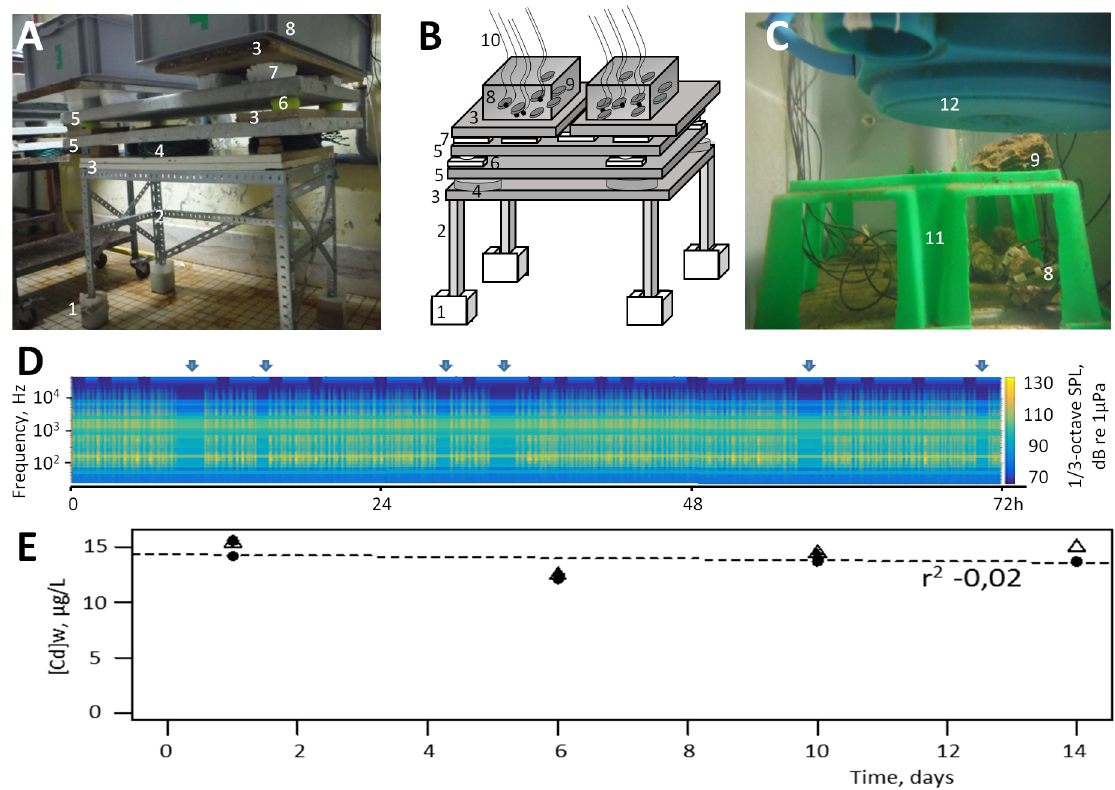
Fig 1. Experimental setup and exposure characteristics. A, antivibration bench with 2 replicate tanks on it; B, complete scheme of a unit; C, inside view of an experimental tank. 1, sand; 2, frame angle structure; 3, chipboard panel; 4, air chambers; 5, concrete slab; 6, tennis ball; 7, pieces of thermal insulation; 8, oysters equipped for behavioral recordings; 9, oysters for tissue sampling; 10, electrode cables; 11, hemstitched support; 12, loudspeaker. D, 72 h of sound recording. Each vertical bar is the noise from one passing cargo ship. Black bands represent periodic absence of cargo ship noise. E: the change of cadmium concentration in the 4 tanks as a function of time. There were 2 antivibration benches and 2 replicate tanks per